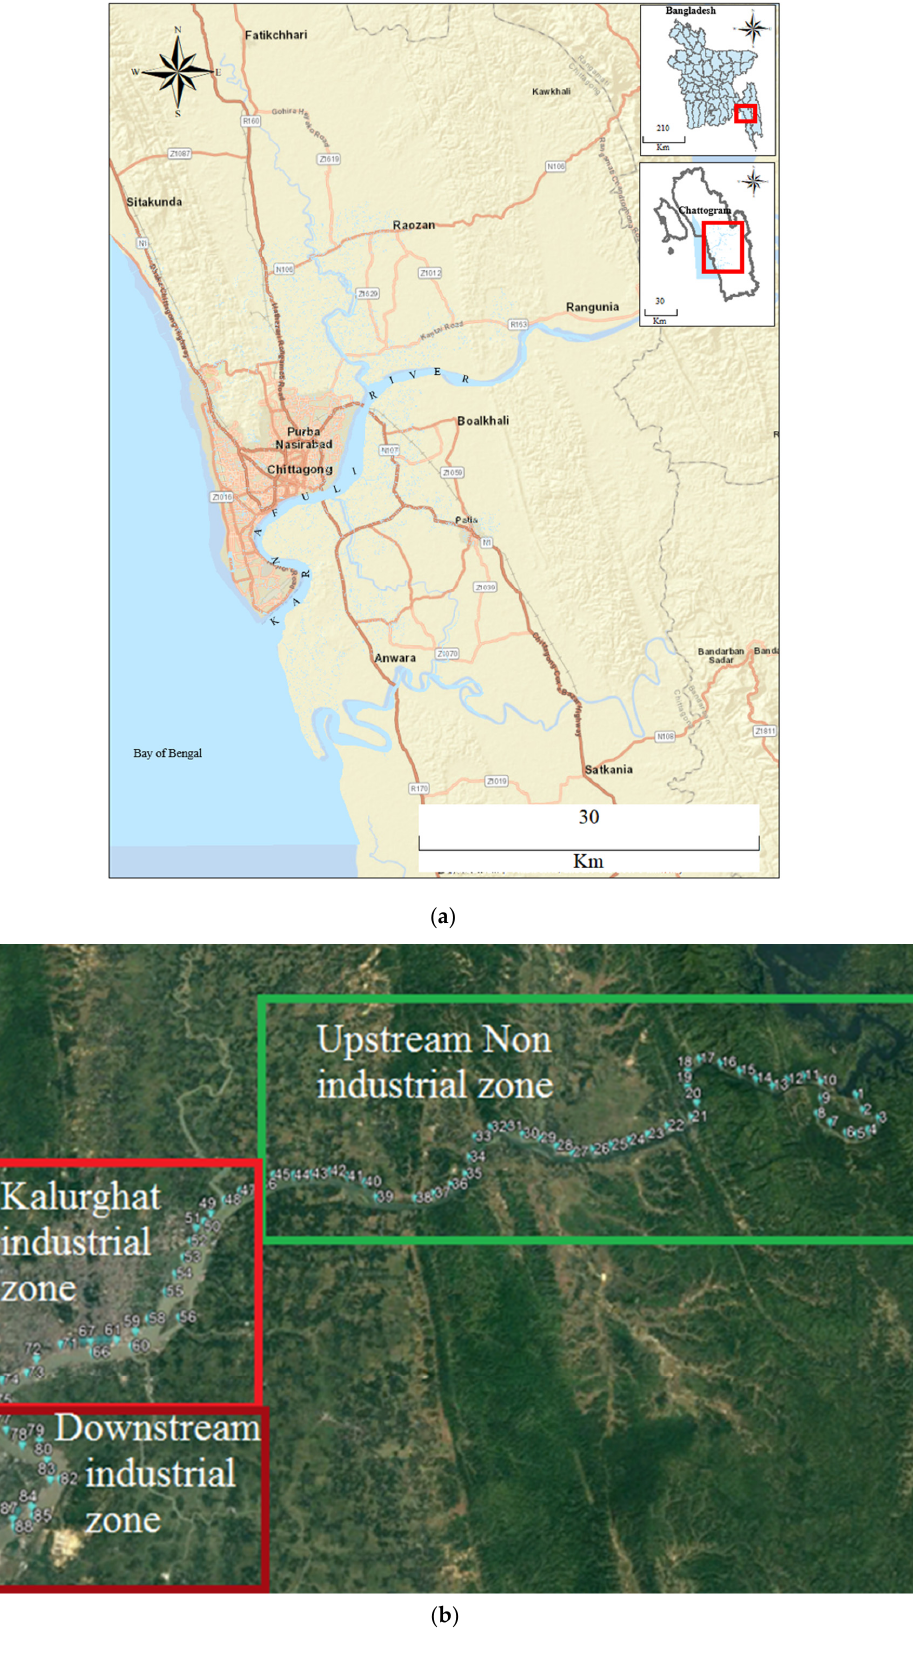
Figure 2. ( a ) Study area. ( b ) Industrial zone in Karnafuli River and sampling